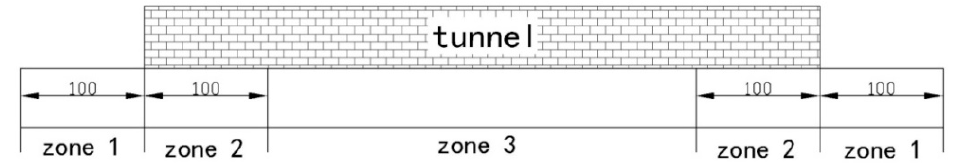
Figure 1. Tunnel Zones.